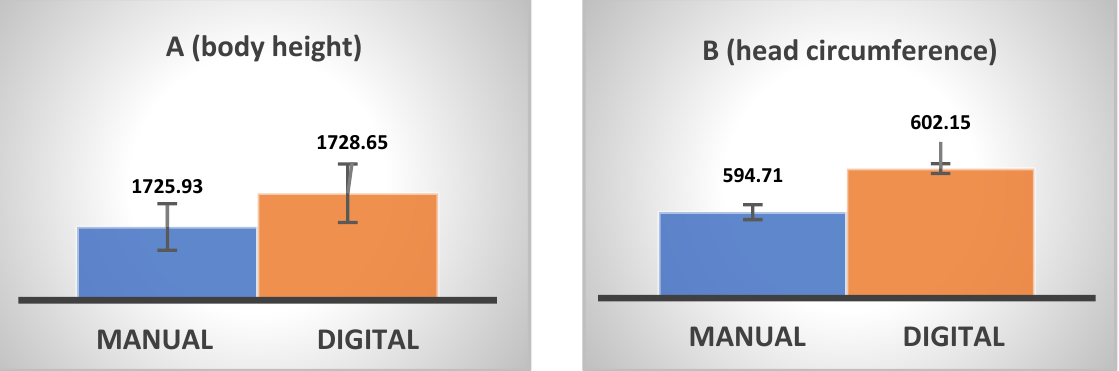
Figure 4. Comparison of manual and digital measurements in terms of body height ( A ) and head circumference ( B